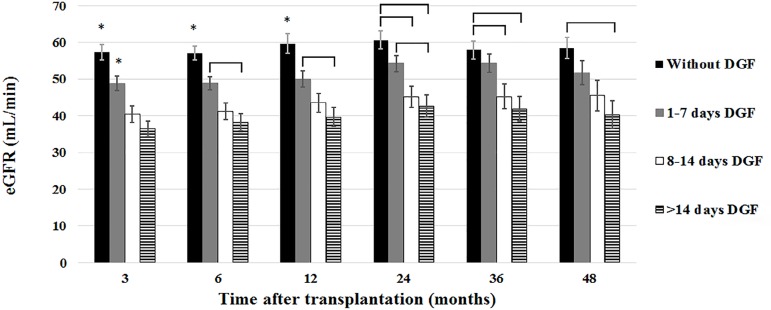
MDRD estimated glomerular filtration rate up to 48 months after
transplantation according to delayed graft function
duration.* P < 0.05 versus all other groups; brackets indicate P<
0.05